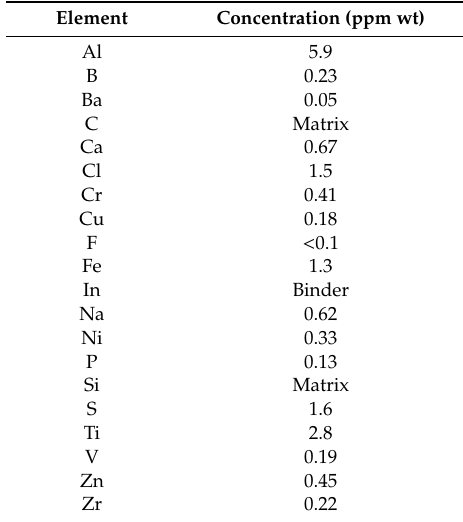
Table 2. Typical chemistry of SIKA High Purity SiC powder as measured by GDMS as provided by the product